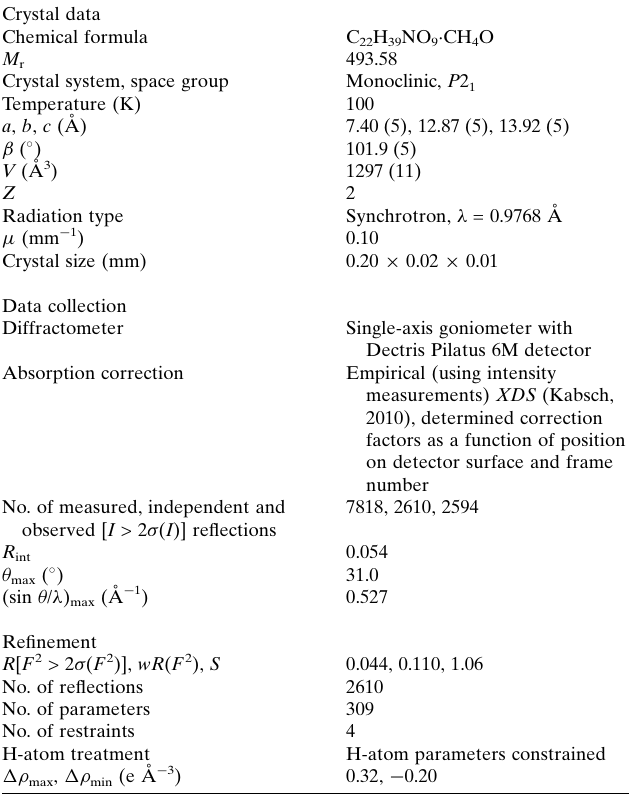
Table 2 Experimental details. Crystal data Chemical